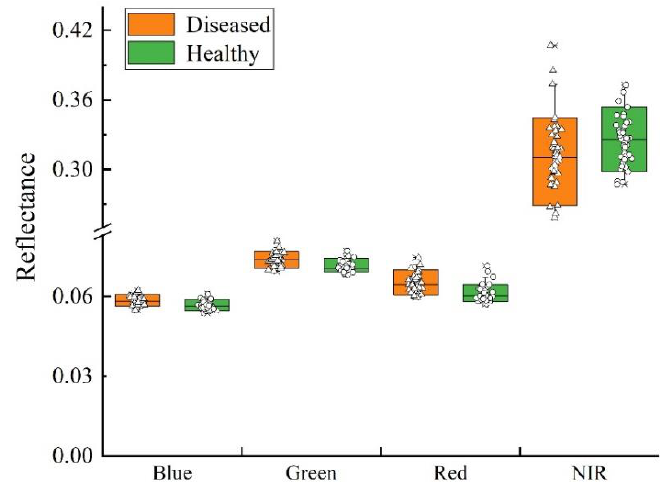
Figure 2. Box-scatterplots of reflectance of healthy arecanut and diseased arecanut.